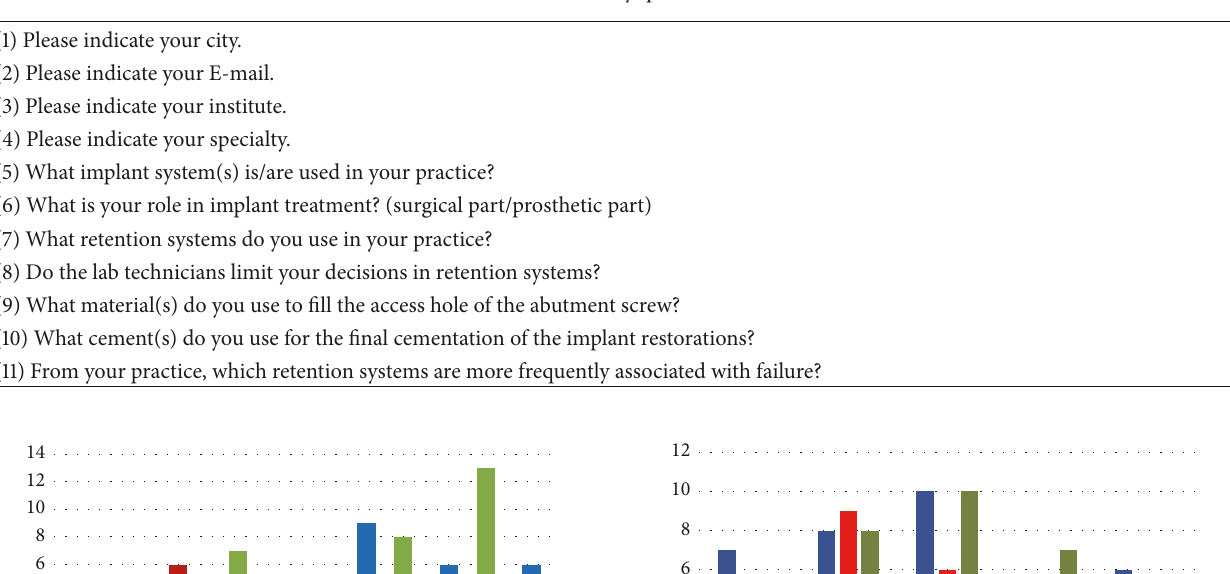
Table 1: Survey questions.